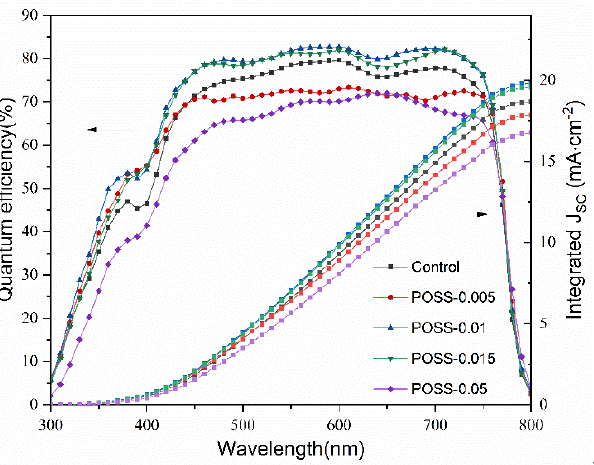
Figure 9. IPCE spectra and integrated J SC of the control cell and the PSCs with various POSS con- tents.